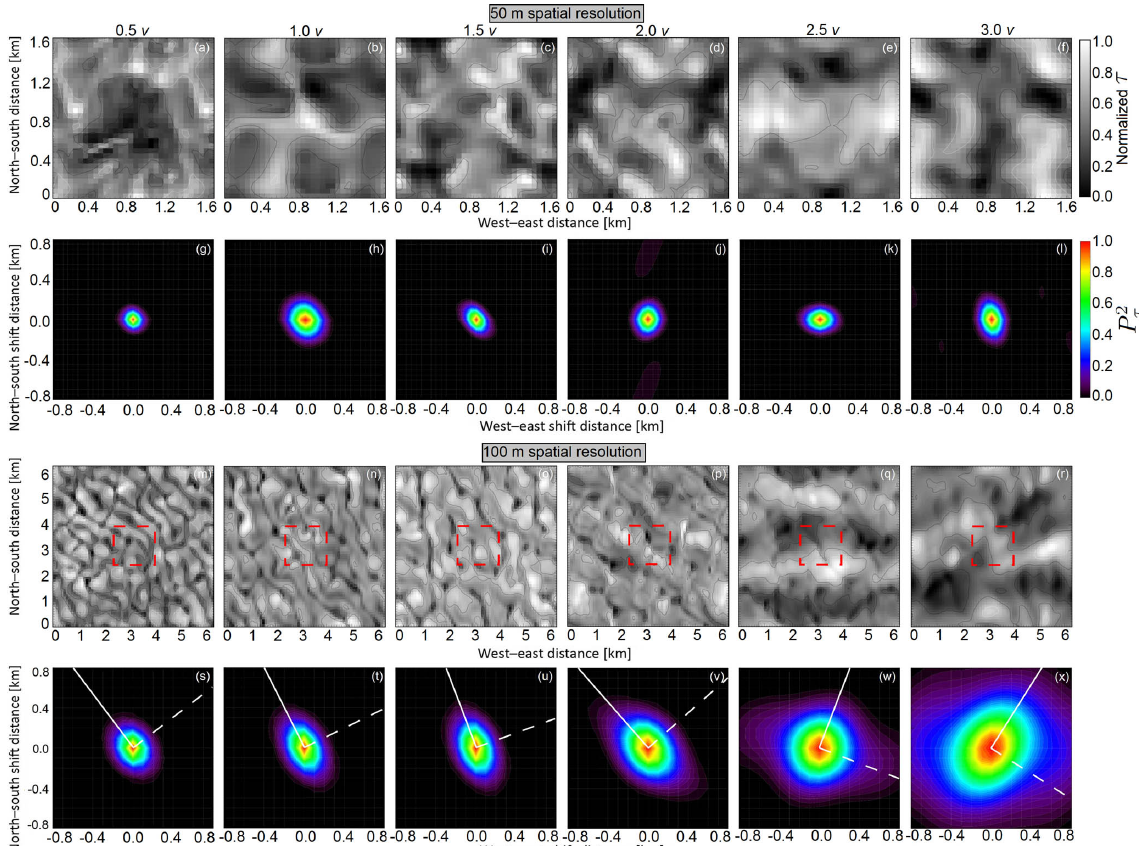
Figure 8. Exemplary selected fields of τ sim for the 15 May 2012 case simulated for differently scaled initial wind speeds on a grid with 50m spatial resolution and 1.6km by 1.6km domain (a–f) and on a grid with 100m spatial resolution and with 6.4km by 6.4km domain (m–r) . Calculated 2-D autocorrelation coefficients P 2 τ are given for each case in panels (g) – (l) and (s) – (x) . White lines in panels (s) – (x) illustrate the orientation used for the calculation of the 1-D P 2 τ along (straight white lines) and across (dashed white lines) the dominant directions illustrated in Fig. 9. Red squares in panels (m) – (r) mark areas of comparable size to the small domains in panels (a) – (f)